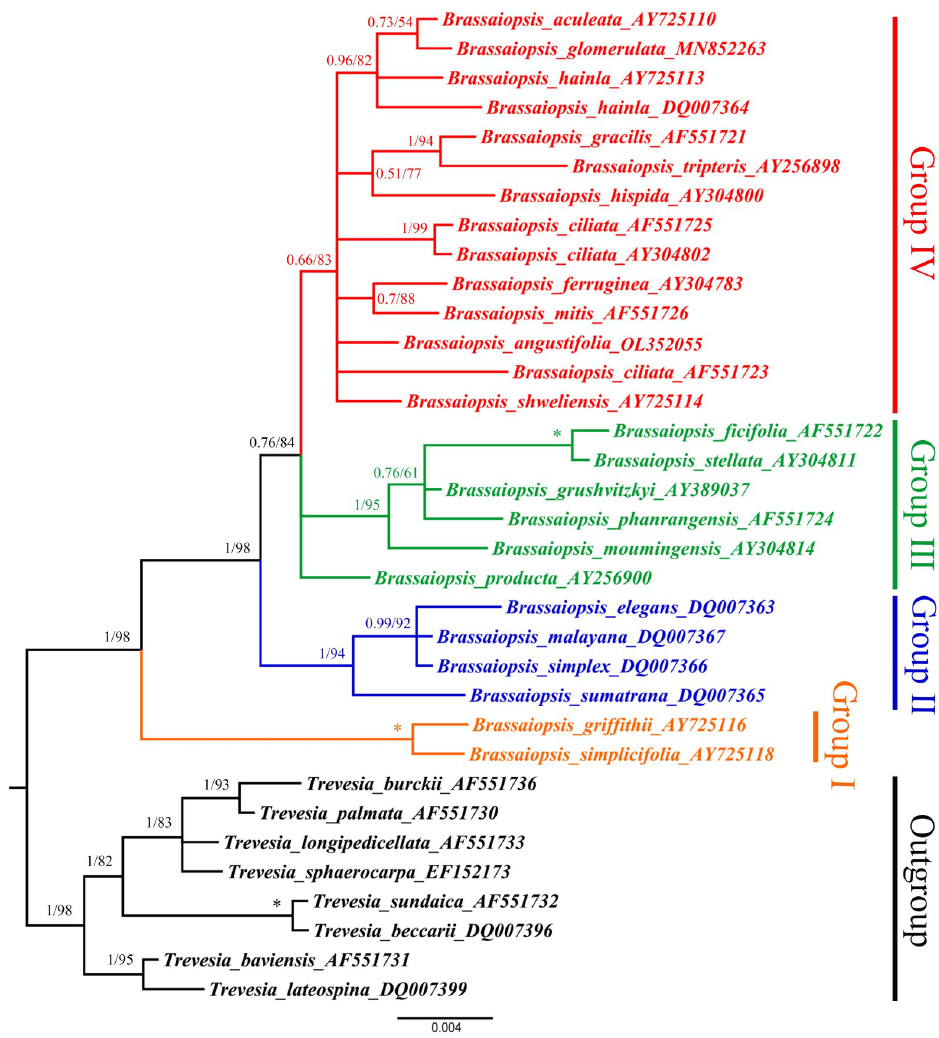
Fig 8. Bayesian inference (BI) and maximum likelihood (ML) strict tree illustrating the phylogeny of the genus Brassaiopsis based on nrDNA ITS datasets. Numbers associated with the branches are BI posterior probabilities (PP) and ML bootstrap values (BS), and asterisks ( � ) indicate BS /PP of 100/1.00. plastome of B . hainla [13], which both possess the typical angiosperm quadripartite structure (Fig 1). The cp genomes are highly conserved for mostland plants. The difference in the size of the IRs and intergenic spacers leads to differences between the cp genomes [42]. Reportedly, the ycf1 and ycf2 genes are located on the border between the IR region and the LSC and SSC regions, and there is incomplete replication of these two genes [13, 43]. Unlike ycf2 , the lengths of the truncated ycf1 genes were different among B . angustifolia , B . hainla , E . brachypus , E . gra- cilistylus , E . senticosus , E . sessiliflorus , E . trifoliatus , K . septemlobus , and M . dispermus (Fig 5). The gene ycf1 passes through the SSC-IRb region, and the truncated ycf1 gene was located in the LSC-IRa region. The change in length of the truncate ycf1 gene directly caused the shrink- age of the IR region in the plastomes of E . gracilistylus and K . septemlobus . In addition, in the M . dispermus , there is a truncated ycf1 gene in the LSC-IRa region; the same phenomenon exists in some species of other angiosperms [44]. Except for B . angustifolia , the ndhF gene is